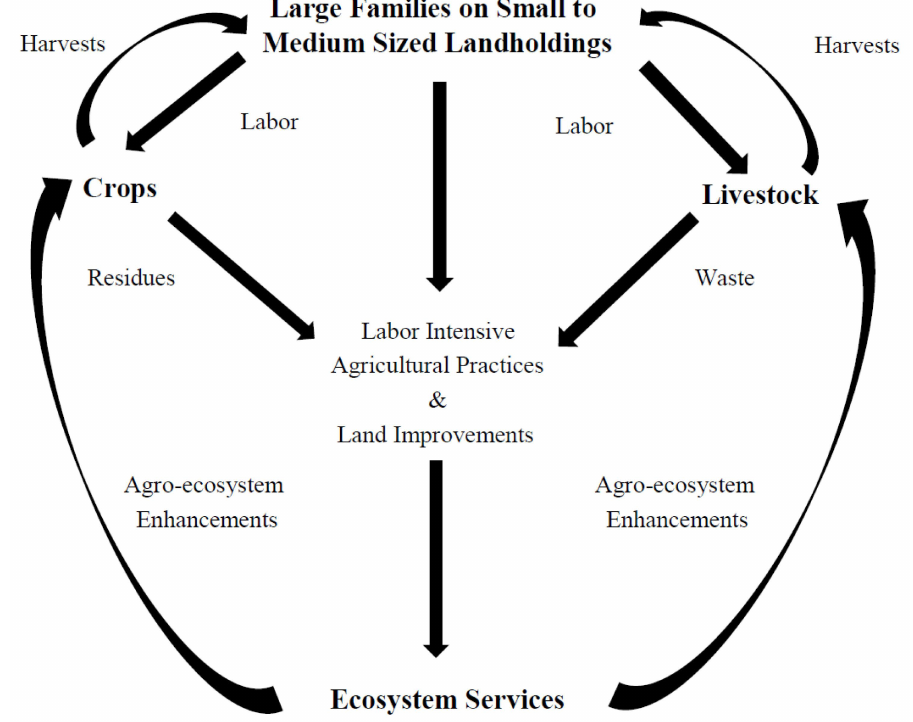
Figure 1. The ecology of small-scale, sustainable agriculture (after Netting,